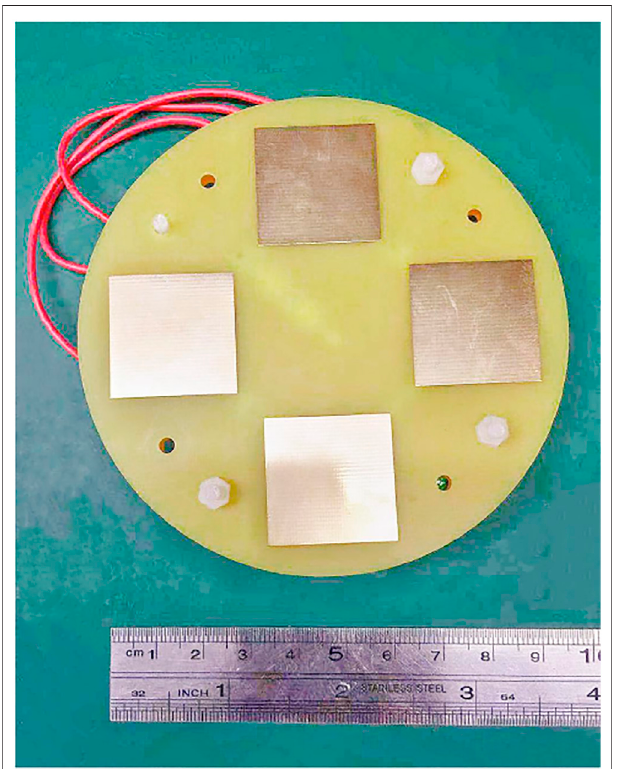
FIGURE 5 | Photograph of the proposed antenna.